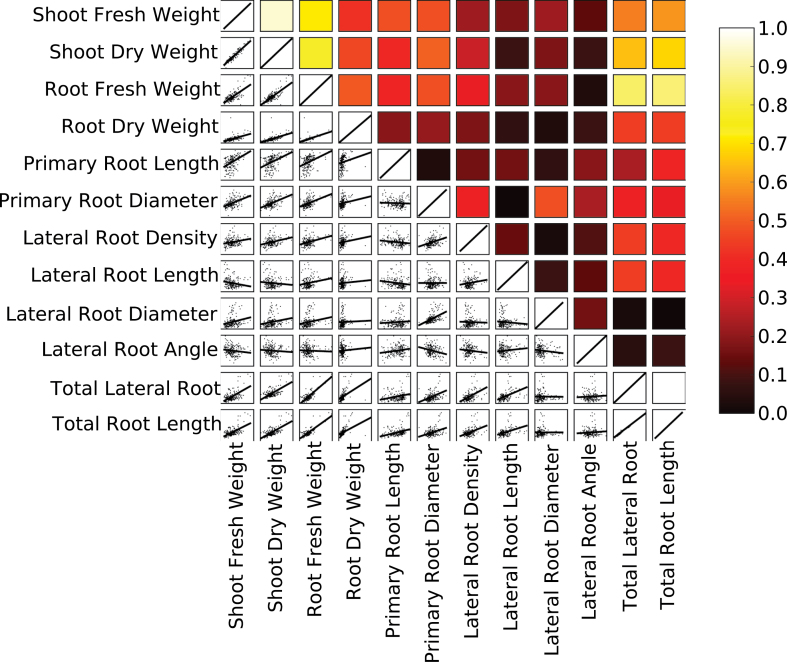
Correlations between plant traits. The plots below the diagonal show linear regressions (red lines) of the data (black points) for different traits. The correlation coefficients for these linear regressions are indicated by the colour of the boxes above the diagonal. The scale of colour codes indicates the correlation coefficients between two traits.